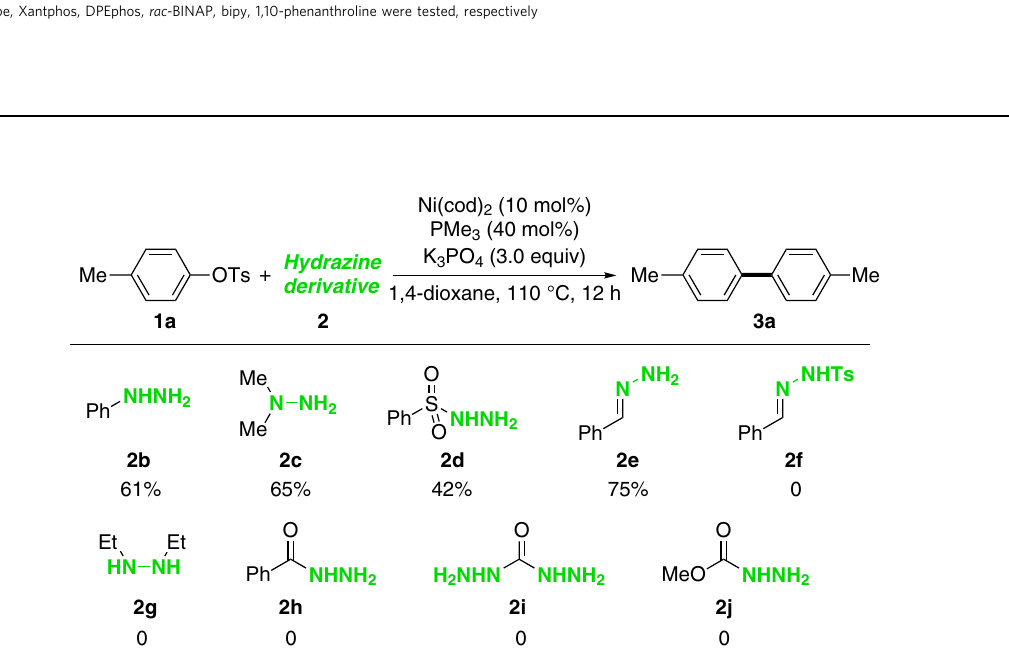
Fig. 2 Exploration of hydrazine derivatives. Reaction conditions: 1a (0.2 mmol), 2 (0.2 mmol), Ni(cod) 2 (10 mol%), PMe 3 (40 mol%), K 3 PO 4 (0.6 mmol), 1,4-dioxane (1.0 mL), 110 °C, 12 h under N 2 . Yields were determined by crude 1 H NMR using mesitylene as an internal standard